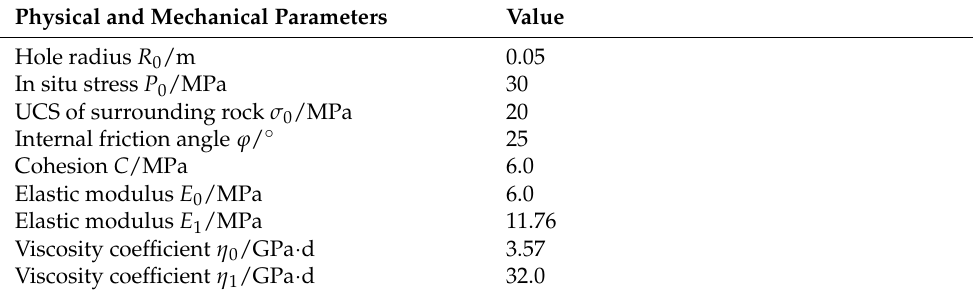
Table 2. Mechanical parameters used for model